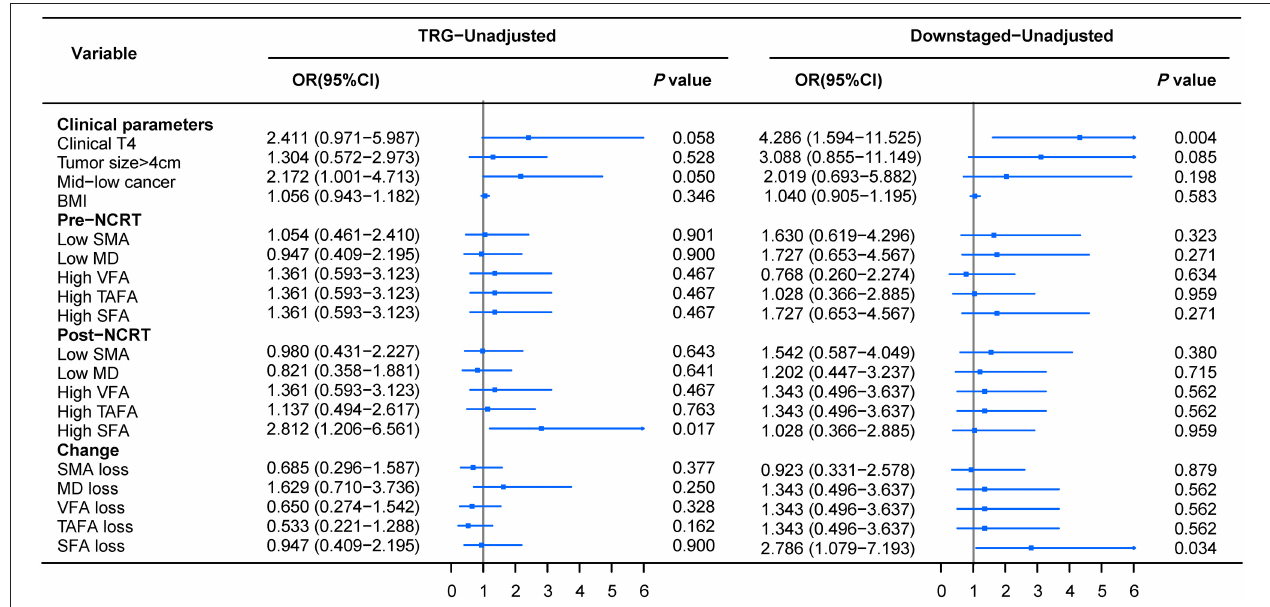
FIGURE 5 | Forrest plot of unadjusted logistic regression to assess the discrimination ability of body composition for tumor TRG and downstaging.